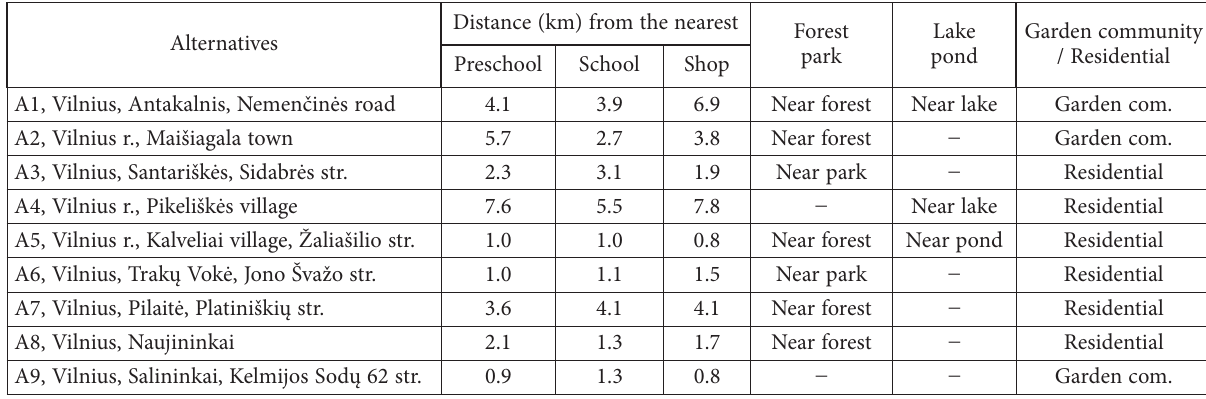
Table 1. Description of